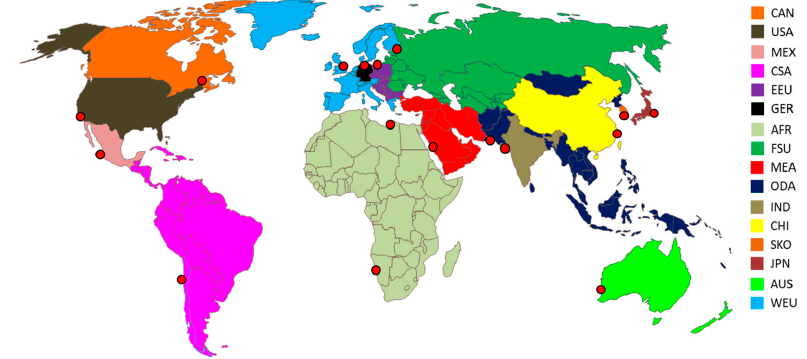
Figure 1. TIAM map with selected harbors (red dots) for each region.